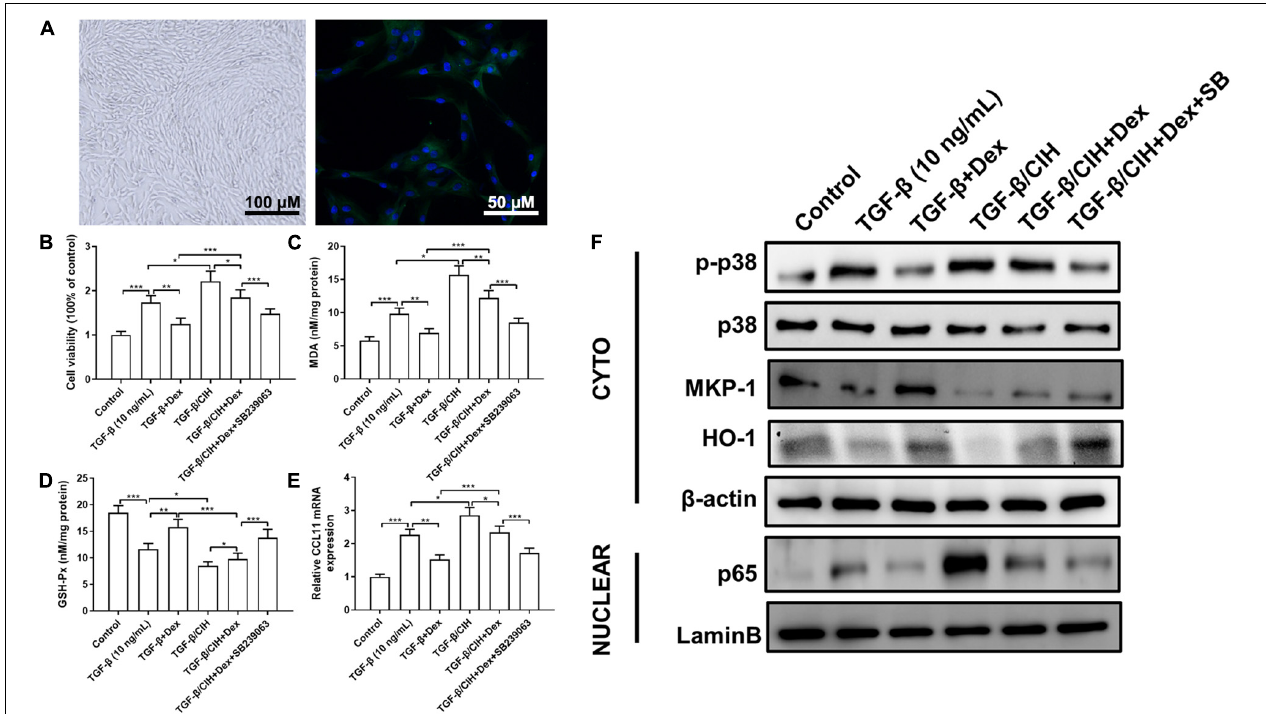
FIGURE 4 | Effects of Dex or the p38 MAPK inhibitor, SB239063, on airway smooth muscle cells (ASMCs). (A) ASMCs displayed the characteristic “hill and valley” appearance. Immunofluorescence staining indicated the expression of the contractile protein SM α -actin (Green). (B) Proliferation of ASMCs at 48 h was analyzed in the different groups. Cell proliferation following TGF- β (10 ng/ml) stimulation was determined by the MMT test. (C) The malondialdehyde (MDA) concentration in ASMCs was measured. (D) Activity of GSH-Px in ASMCs was measured. (E) The level of CCL11 mRNA expression in ASMCs was determined by qRT-PCR. (F) The levels of phosphor-p38, MKP-1, HO-1, and nuclear p65 protein in ASMCs were determined by western blotting. Data are shown as the mean ± SEM ( n = 3; * p < 0.05; ** p < 0.01; *** p <